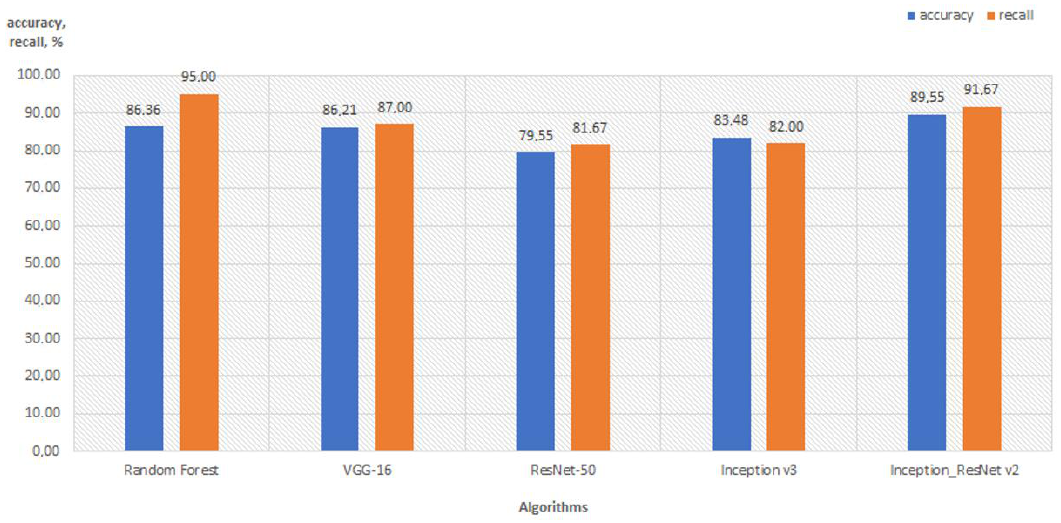
Figure 7. Comparison of Random Forest Classifier and deep earning